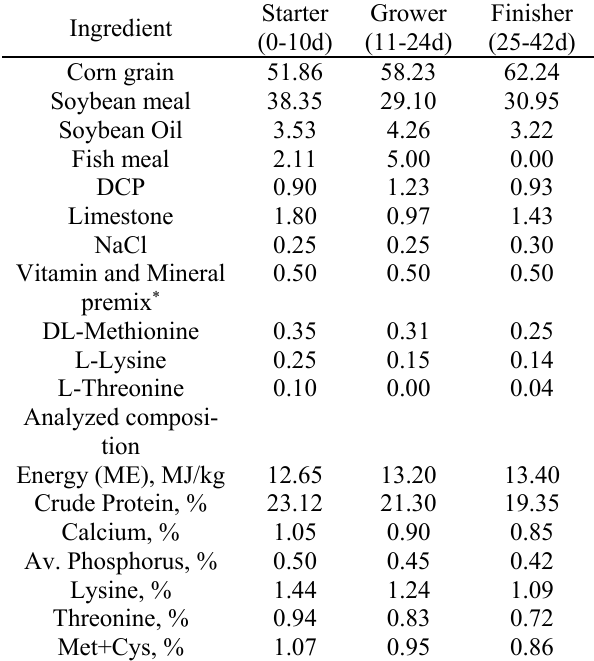
The experimental diet used in starter, grower and finisher period of